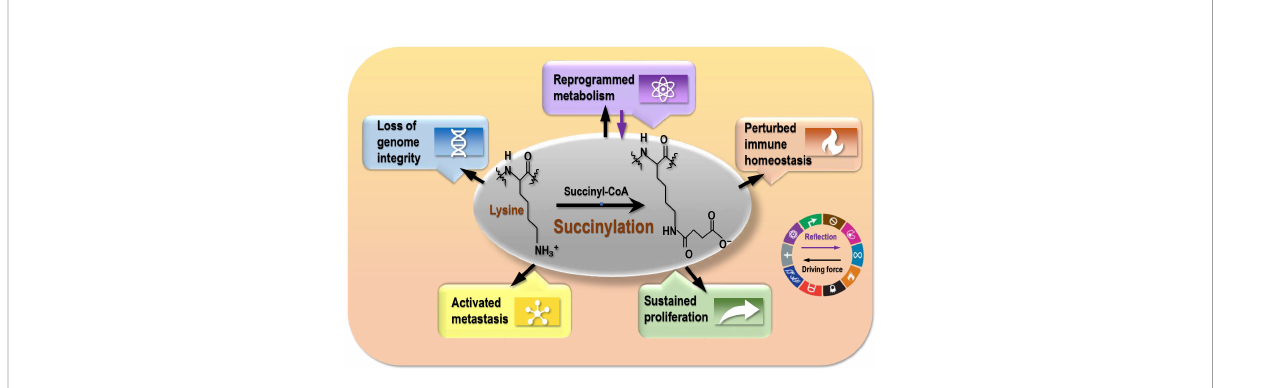
FIGURE 2 The driving role of succinylation on cancer hallmarks. Succinylation is a re fl ection of reprogrammed metabolism of cancer cells, and drives cancer hallmarks that are represented by ‘ reprogrammed metabolism ’ , ‘ sustained proliferation ’ , ‘ activated metastasis ’ , ‘ perturbed immune homeostasis ’ , and ‘ loss of genome integrity ’